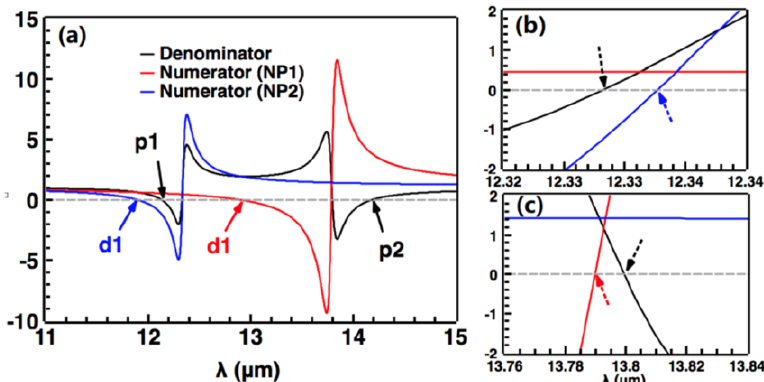
Figure 4. ( a ) Calculated results of denominator term 1 − α 1 α 2 A 12 A 21 (black) and numerator terms 1 − α 2,1 A 12,21 (red for NP1 and blue for NP2) in the function of incident wavelength. ( b , c ) are the local enlarged images cut from ( a ), located around 12.3 µ m and 13.8 µ m, respectively. The physical parameters used in the calculation are the same as in Figure 2IV.